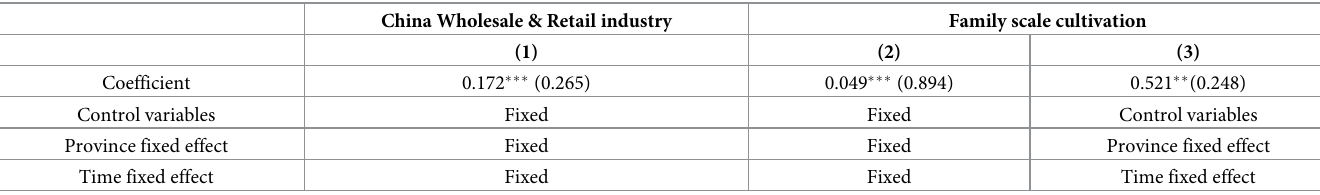
Table 8. The effect of broadband construction on wholesale retail and scale